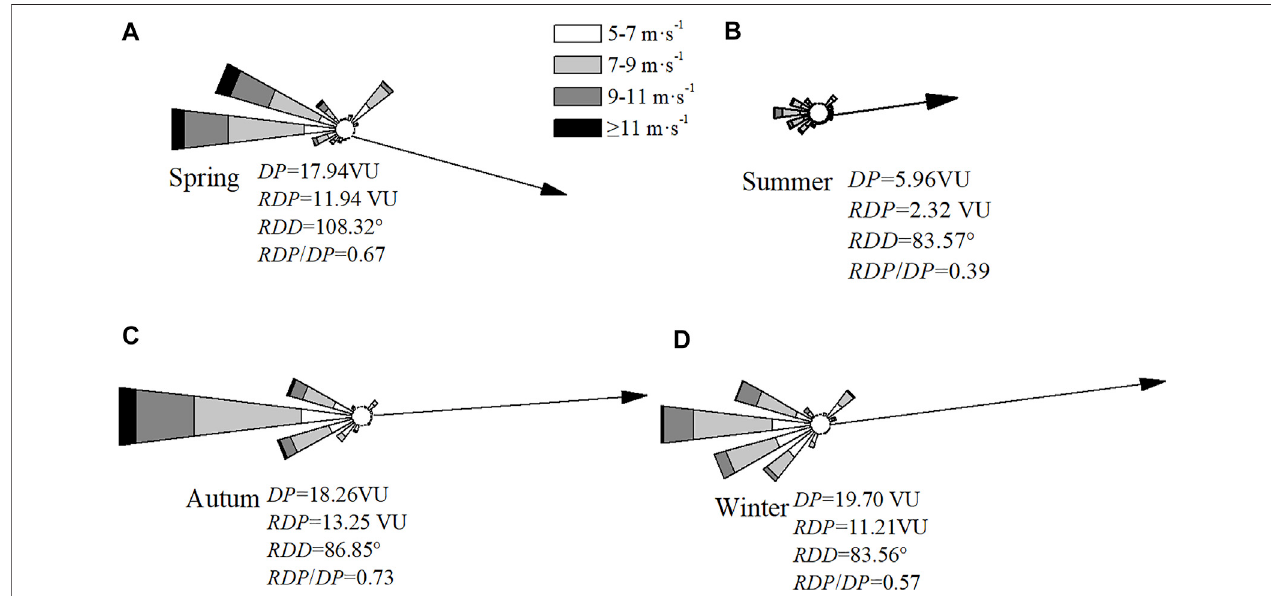
FIGURE9| Driftpotentialintheoasisin (A) spring, (B) summer, (C) autumn,and (D) winter.Thecalculatedresultantdriftpotential(RDP)andresultantdriftdirection (RDD) are shown in black arrow.